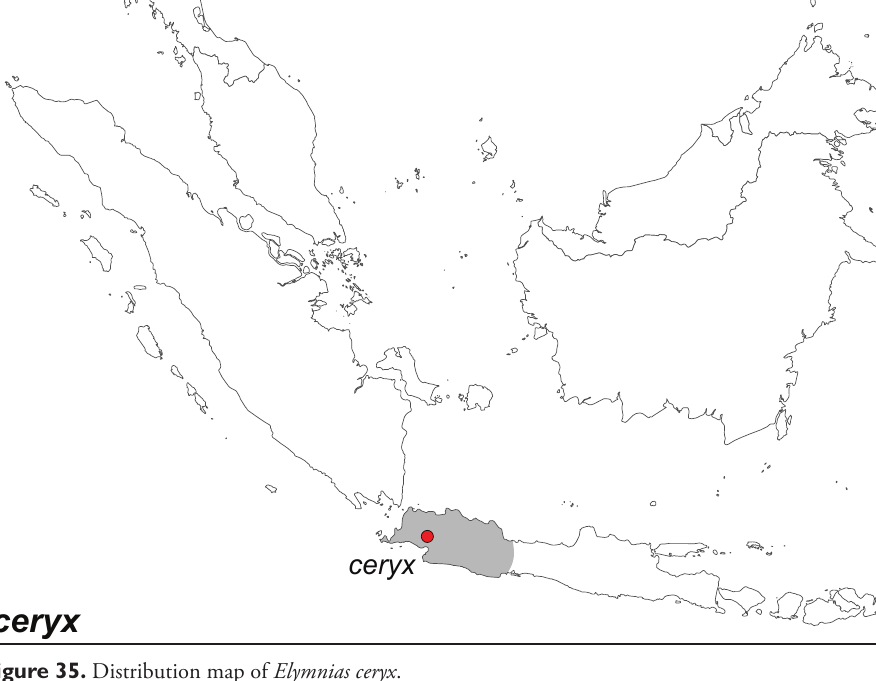
Figure 35. Distribution map of Elymnias ceryx .